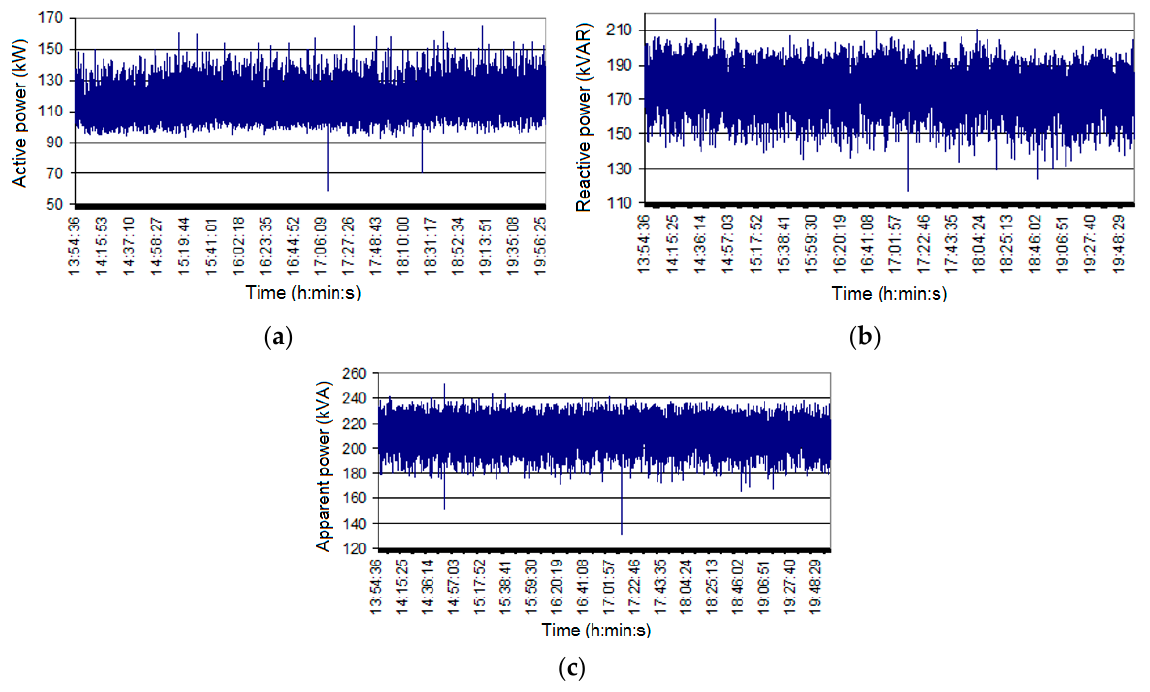
Figure 20. The RMS current values in the primary of a step ‐ up transformer for an ESP with three sections: ( a ) current L1; ( b ) current L2; ( c ) current L3.